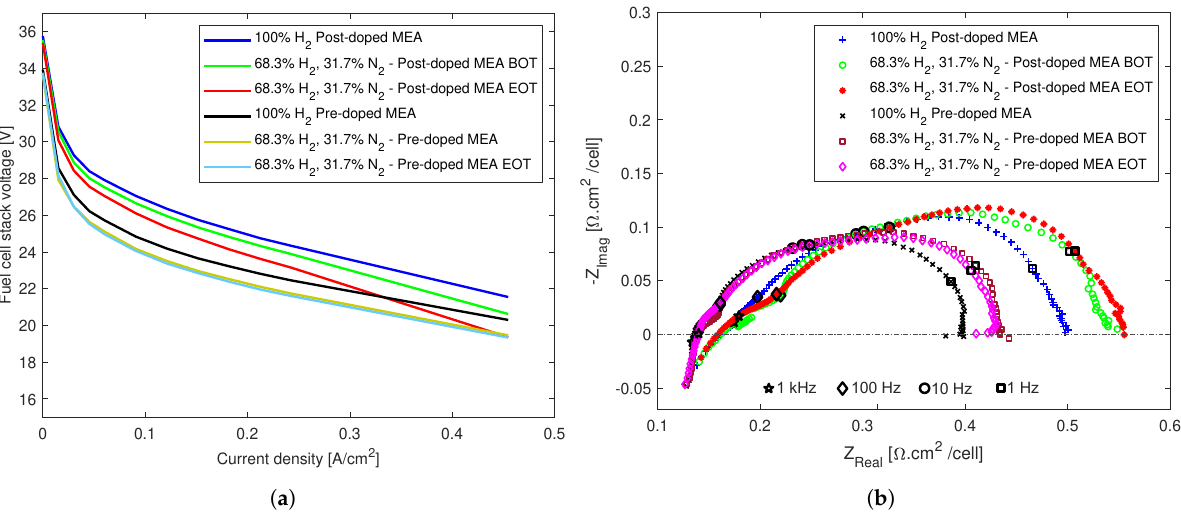
Figure 4. The effects of N 2 dilution on both stacks. ( a ) Polarization curves. ( b ) EIS spectra. All the high frequency real axis intercepts in the Nyquist plot lay on top of each other, implying that the ohmic resistance was not affected by dilution. However, there is a size increase of the impedance spectra in all frequency regions, which implies performance losses, perhaps due to reduced triple phase boundaries as a result of the acid redistribution and eventual loss of excess